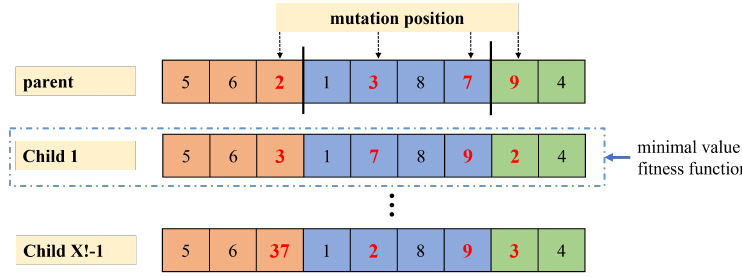
Figure 8. Schematic diagram of the heuristic operator.